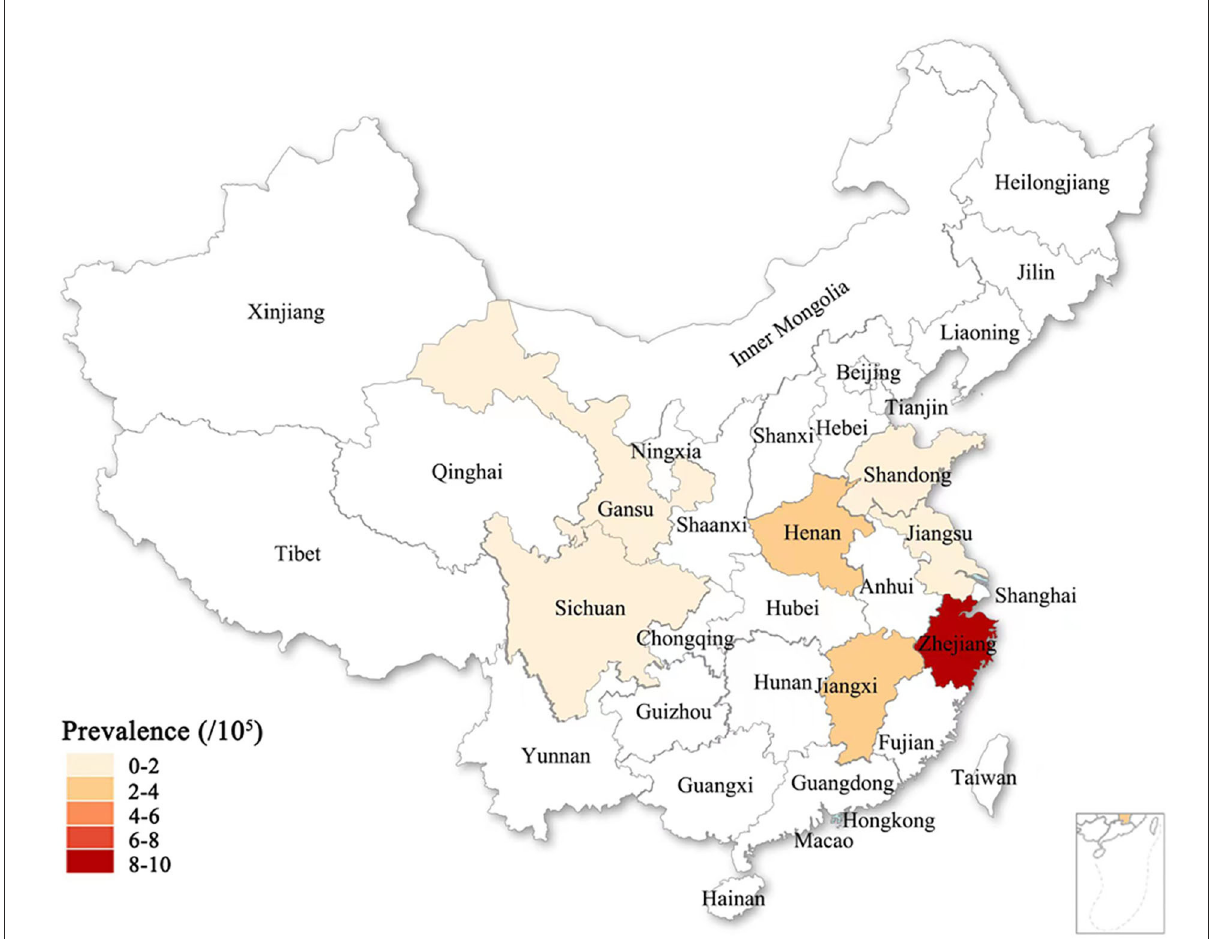
FIGURE5 The ALS prevalence in seven provinces of the Chinese mainland in this survey was exhibited on the Chinese map. The deep and shallow color indicated the high and low of ALS prevalence. Deeper color indicated higher ALS